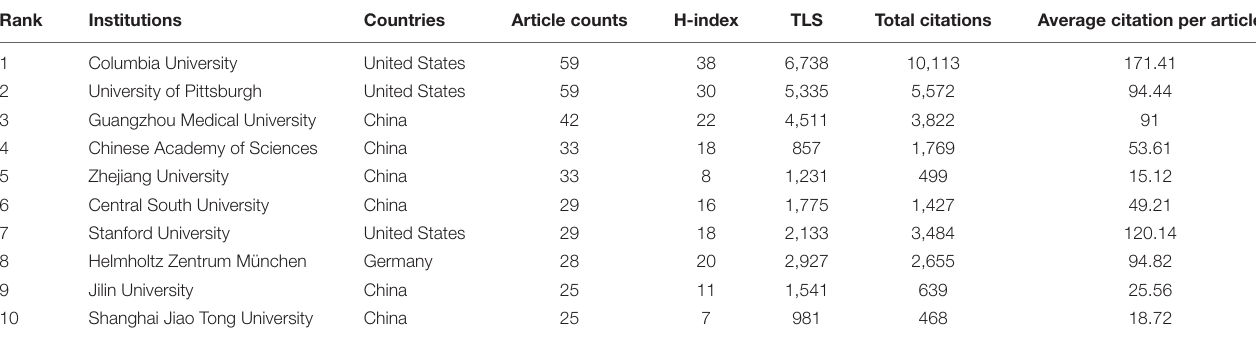
TABLE 2 | The top 10 productive institutions ranked by the numbers of